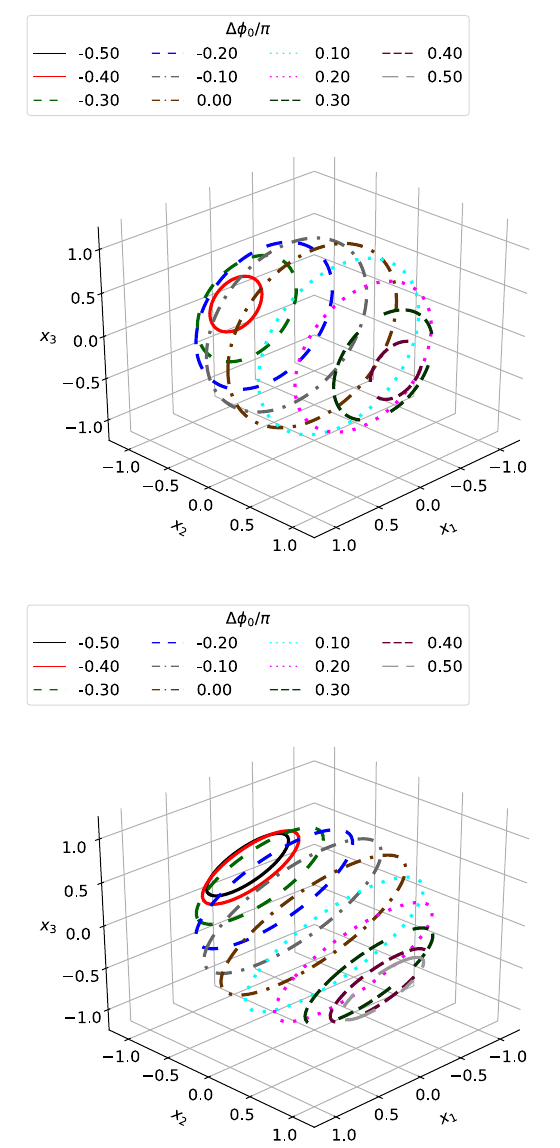
FIG. 7. Representation of on-resonance ( q ¼ 0 , top) and off- resonance ( q ¼ 0 . 5 , bottom) solutions in the coordinate system defined in Eq. (7).